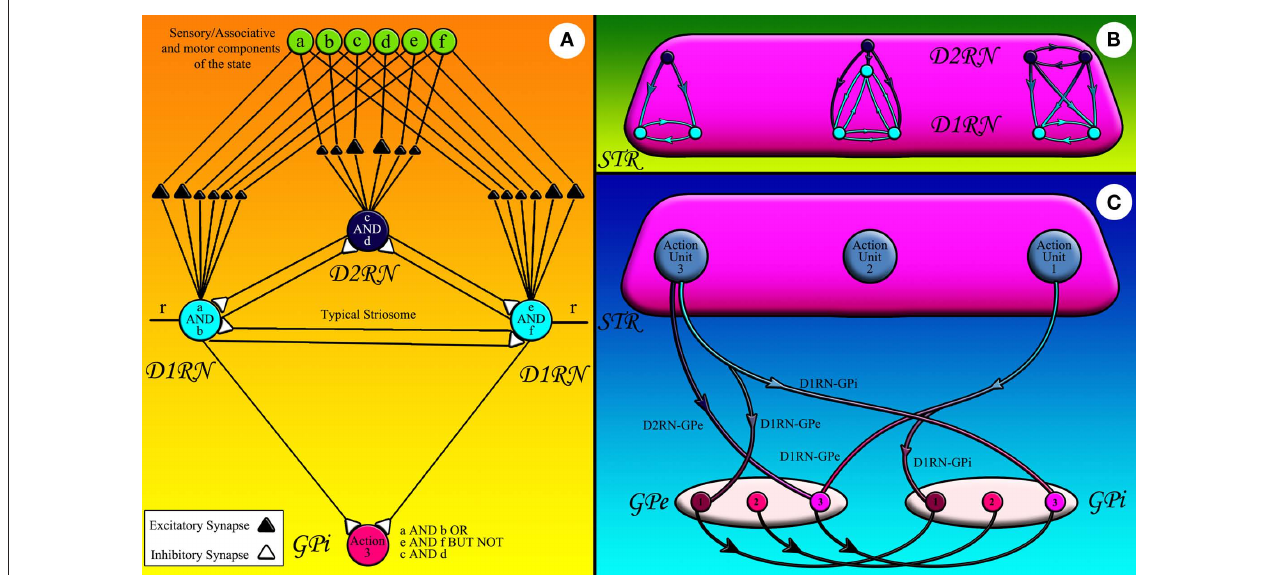
neuron. r is the input from CM. (B) The inhibitory collaterals within a matrisome have diverse connectivity patterns corresponding to the state they record. (C) The D1RNs in the matrisome of a certain action unit inhibit the GPi/SNr neuron attached to that action unit while sending collaterals to the GPe neurons of competing action units (the light blue axons). The D2RNs in the same action unit however, project to the corresponding GPe neuron (dark blue